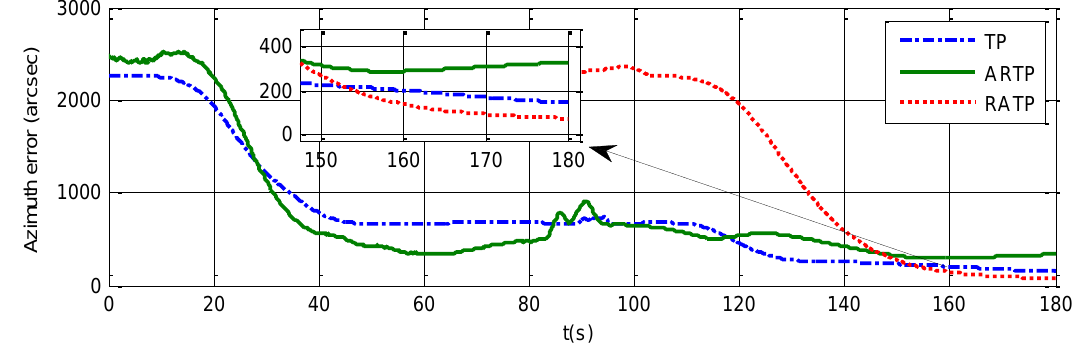
Figure 9. Azimuth error time history curve angular vibrations with an amplitude of about 10 arcsec and a random frequency between 5 and 10 Hz when the total alignment time is 180 s.